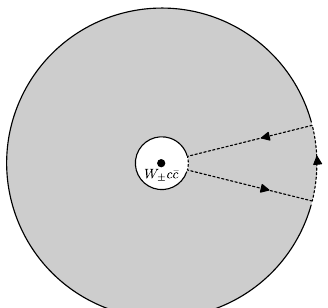
Figure 18 . BRST Invariance . The physical vertex operator W ± c ¯ c is BRST invariant and prepares a BRST invariant state in the sense of radial quantization. The thermal state of angular quantization prepared with an asymptotic insertion of W ± c ¯ c is likewise BRST invariant. With the neighborhood of the insertion excised from the worldsheet and replaced by the appropriate asymptotic conditions on the resulting boundary circle, the BRST current vanishes on the circle in the limit that it shrinks away. Because the line integral of the current around the dashed loop shown vanishes by current conservation, it follows that the BRST charges measured on the two radial slices are